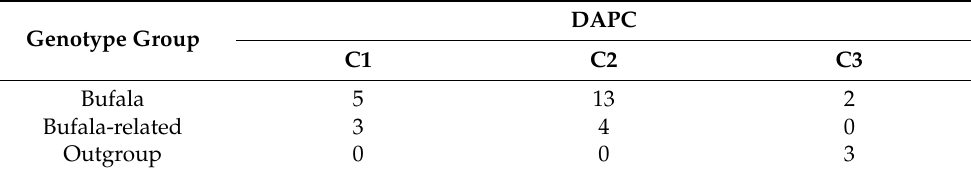
Figure 2. Scatterplot of the first two principal components of the DAPC. A minimum spanning tree connects the three groups. Numbers and colors identify the clusters. LD: loadings. Table 3. Distribution of genotypes in three clusters obtained by discriminant analysis of principal components (DAPC).